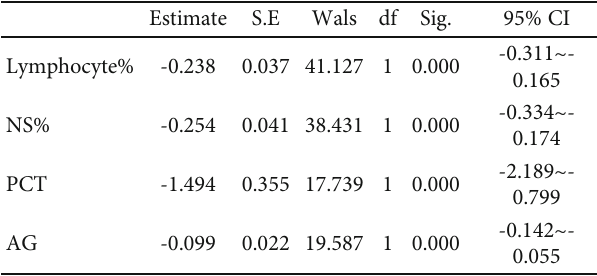
Table 3: Multiple logistic regression analysis of independent factors associated with blood eosinophils in AECOPD ( n = 455 ). Estimate S.E Wals df Sig.